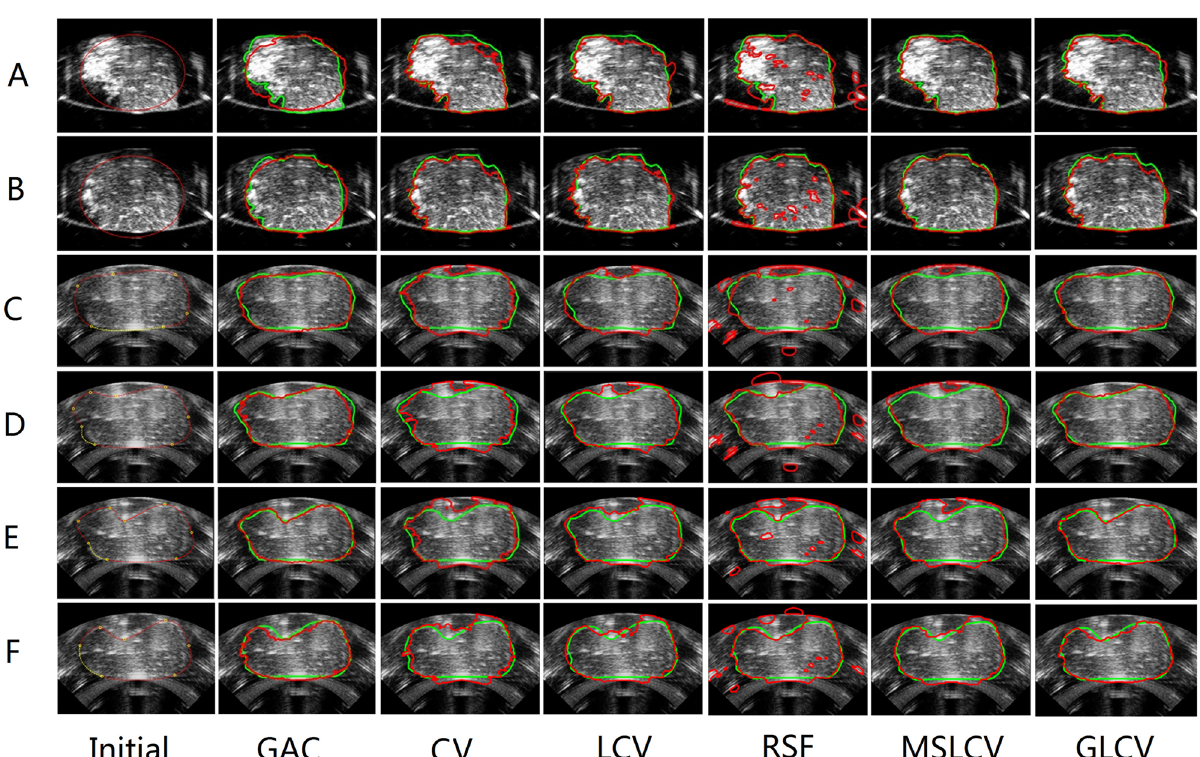
Fig 2. Comparison of the GLCV and five other methods by applying them to segment six HIFU ultrasound images. The first column shows the original images and the initial contours. For images A and B, the initial contour is an ellipse, and for images C, D, E and F, the initial contours are defined by 5 – 7 connecting points. Columns 2 to 7 show, respectively, the segmentation results for GAC [19], CV [20], LCV [22], RSF [23], MSLCV [24] and GLCV. The green curves are manual segmentation results by an experienced doctor as the ground truth, and the red curves are the final segmentation contours from these